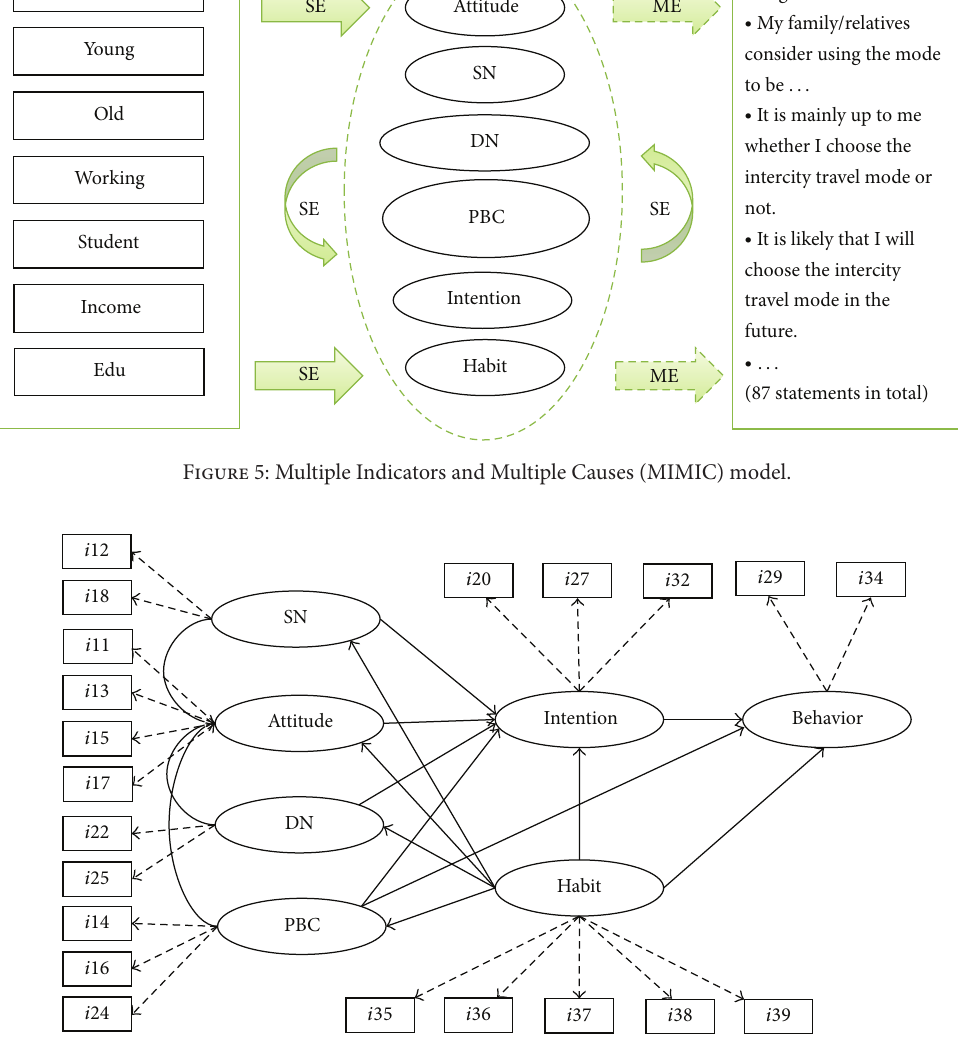
Figure 6: Detailed path analysis